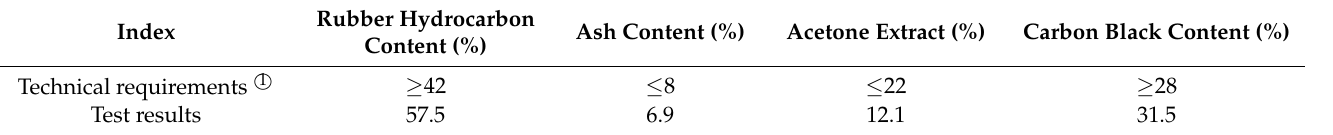
Table 4. Chemical indicators of crumb rubber.